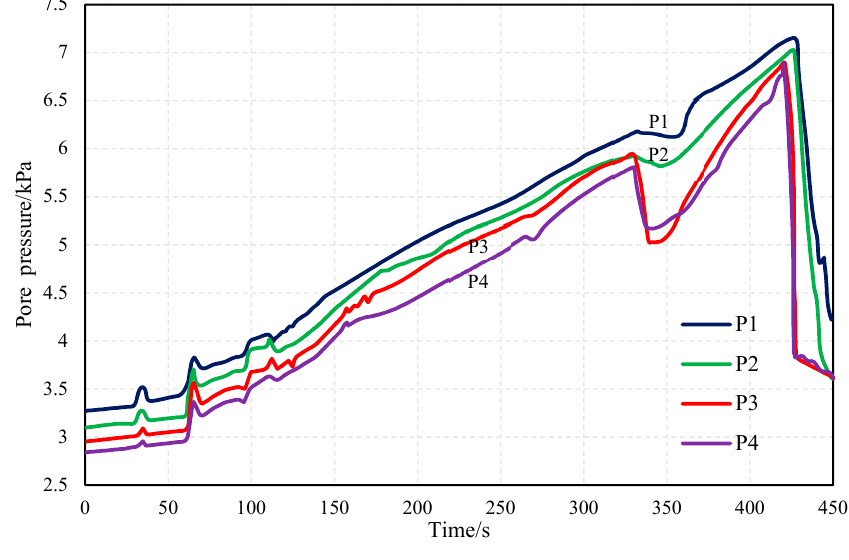
Figure 15. Measured pore pressure in Model 20-5.